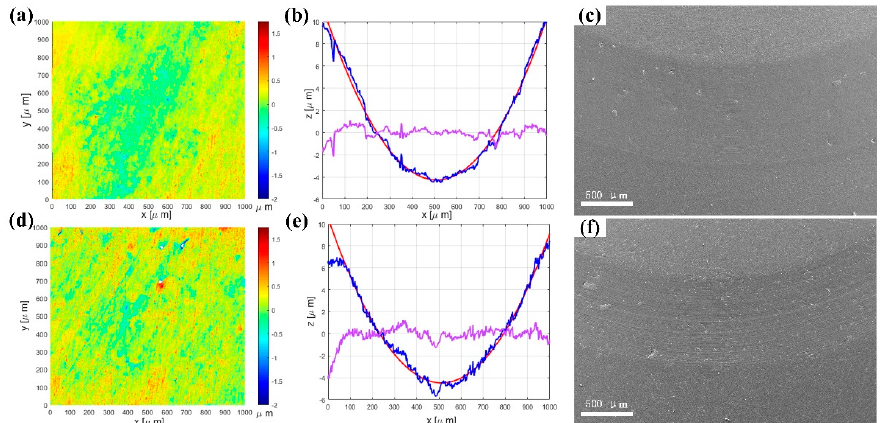
Figure 11. The surface topographies, wear track profiles and SEM images of polished PA 12 ( a – c ) and SiC/PA12 composites ( d – f ).